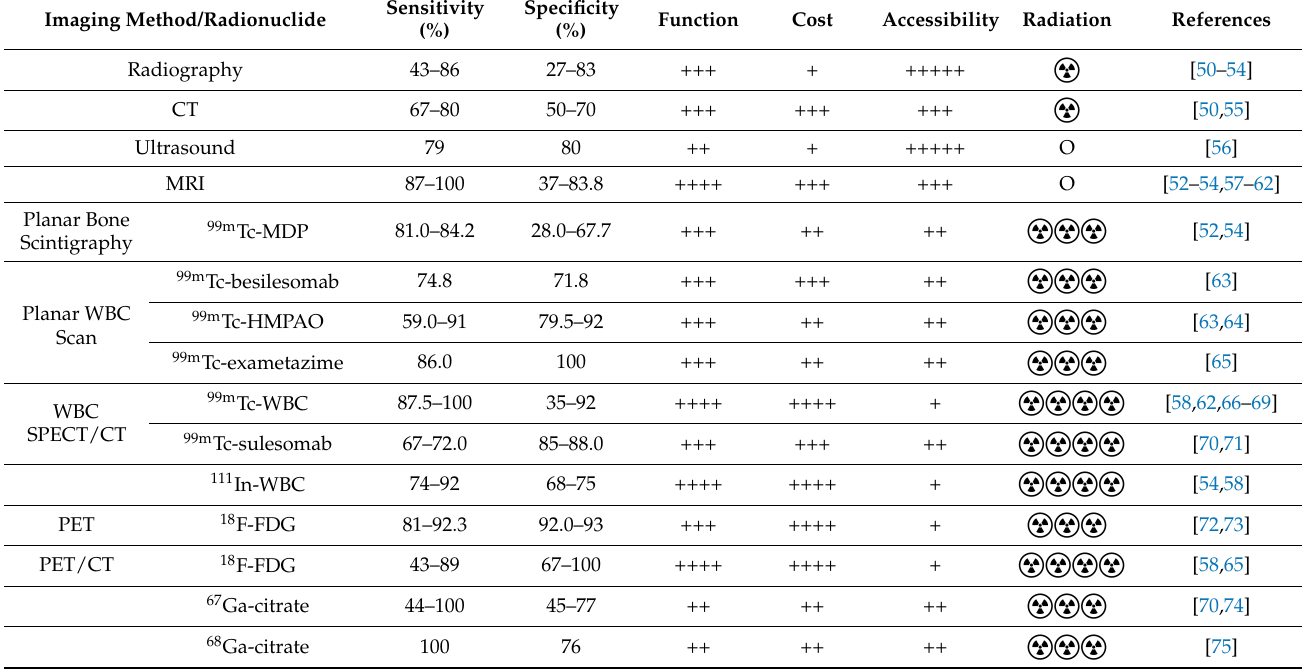
Table 1. Diagnostic Imaging Modalities for Diabetic Foot Infections.